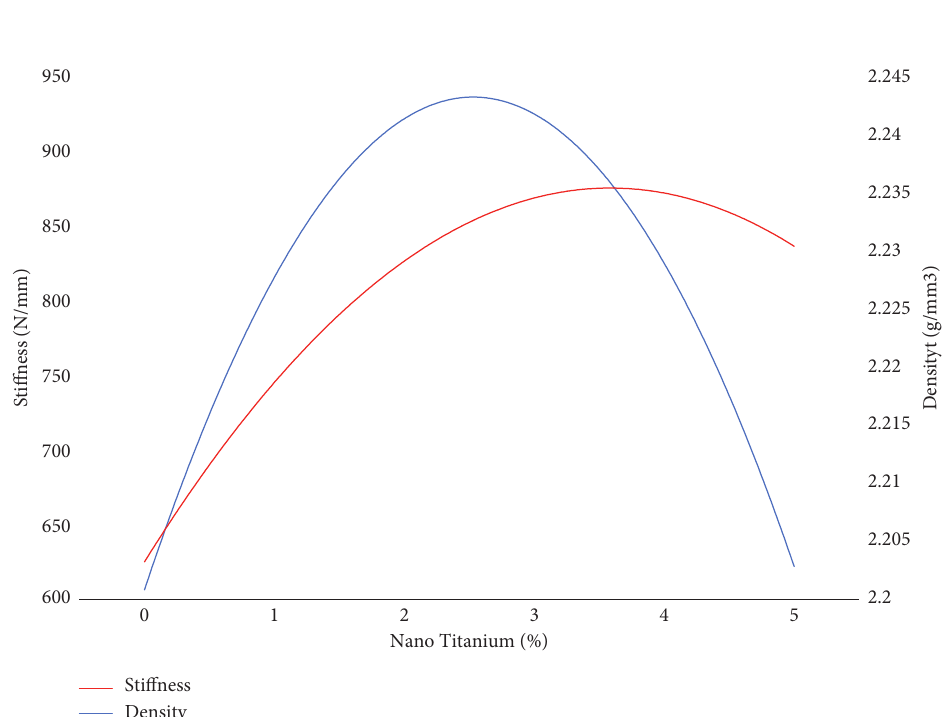
Figure 13: Stiffness and flow against nano TiO